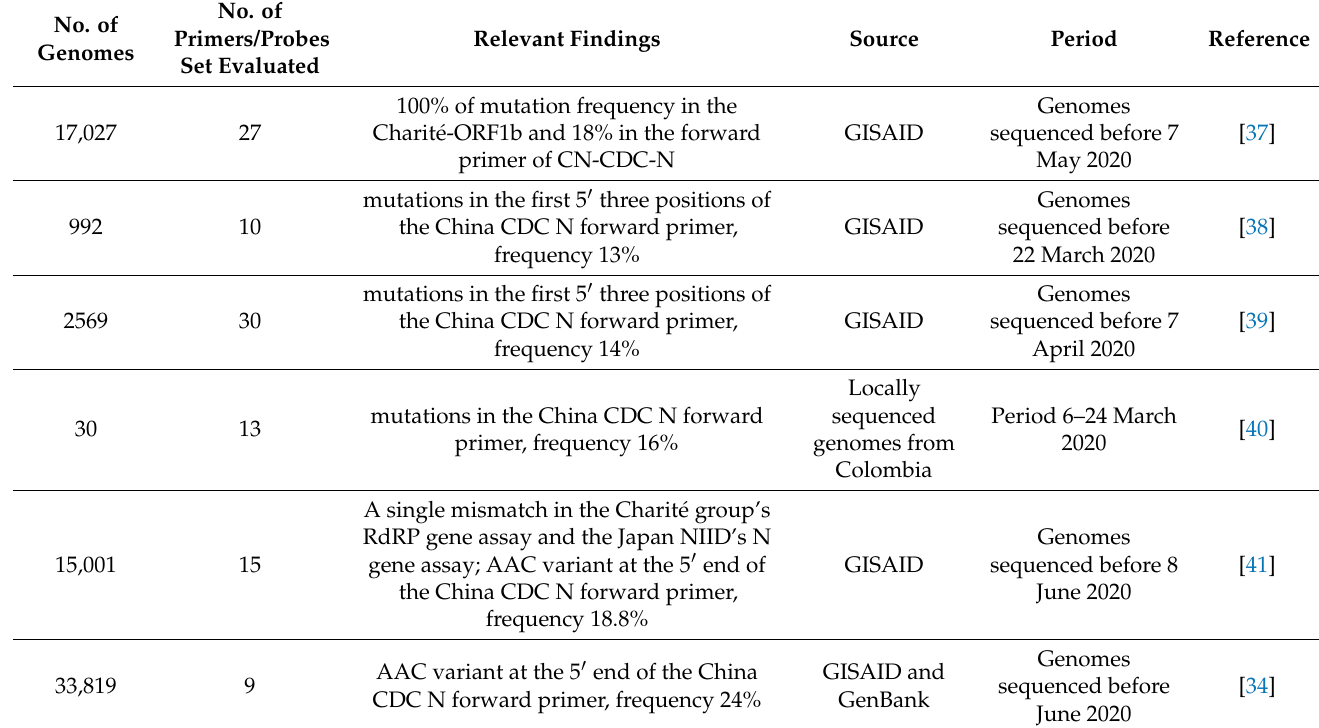
Table 4. Summary of previously published papers analyzing the presence of mismatches between publicly available RT-PCR primers/probes and SARS-CoV-2